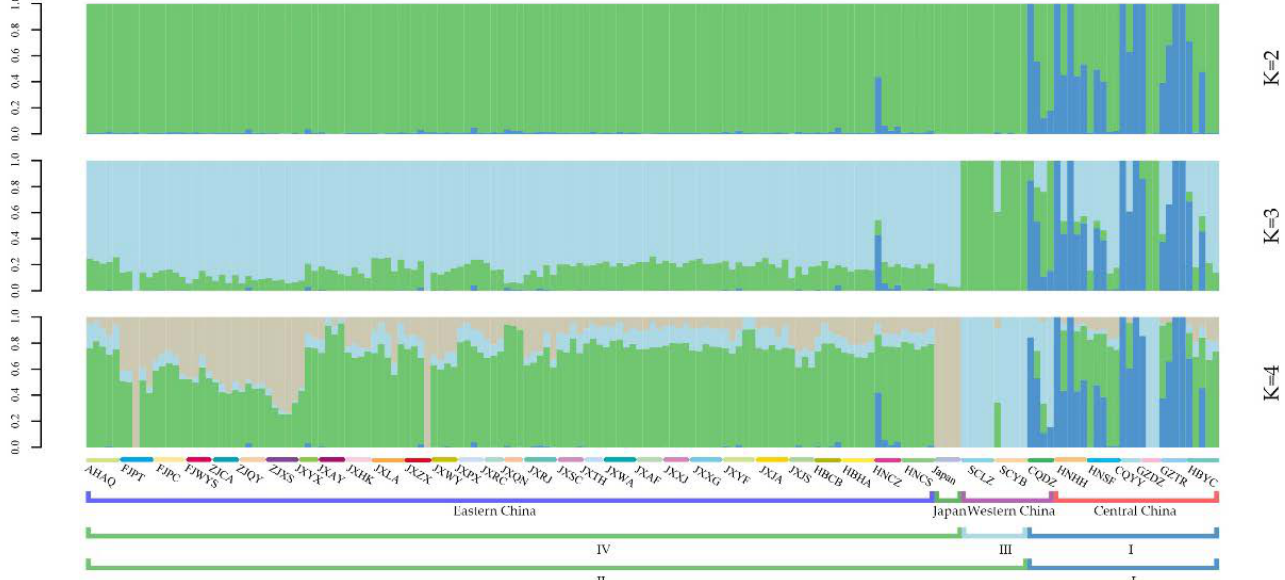
Figure 3. Population genetic structure of 171 C. camphora individuals. Each colour represents one cluster. Each individual is represented by a vertical bar, and the length of each coloured segment in each vertical bar represents the proportion contributed by ancestral populations.